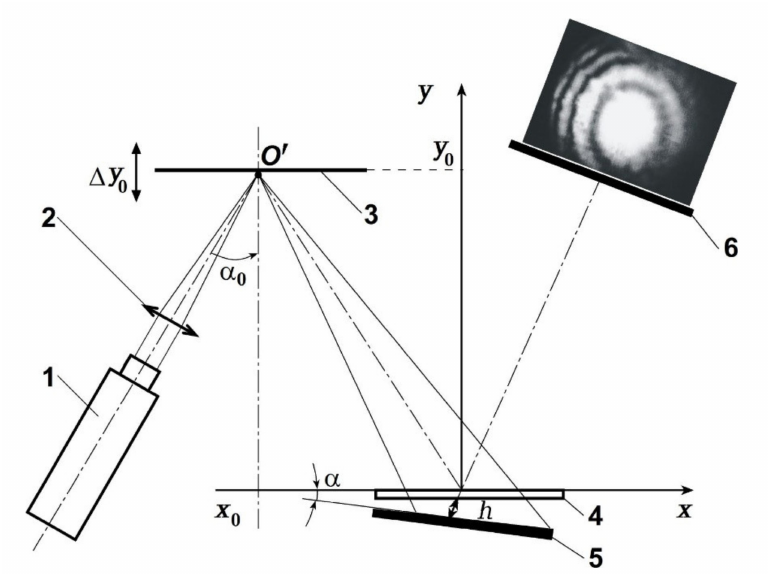
Figure 1. Scheme illustrating the “luminous point” method: (1) source of coherent optical radiation (He–Ne laser with a wavelength of 0.63 µ m); (2) optical device, namely optical elements—lenses focusing laser radiation on the surface of the control object in the form of a “luminous point”; (3) the surface of the control object, in the experiment—a simulator of the surface of the control object in the form of an optical mirror with a surface coating, designed to simulate the displacements of the surface of the control object; (4) beam splitter, in the experiment—a holographic diffraction grating, similar to that used in [33]; (5) reflector, an optical mirror with a surface coating; (6) photodetector, in the experiment—a screen in the form of frosted glass, behind which a digital camera is installed, 24